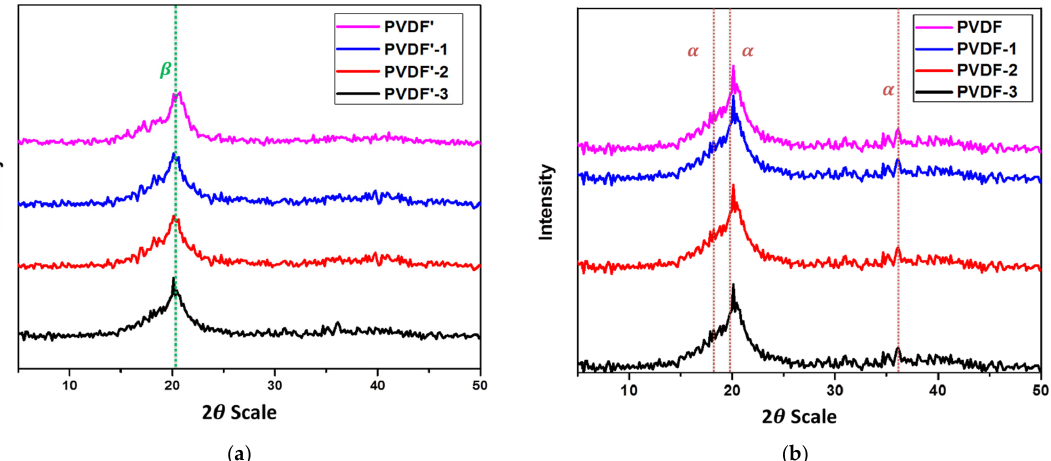
Figure 4. FTIR spectra of ( a ) electrospun PVDF fibrous membrane prepared in 100/0, 80/20, 60/40, and a 50/50 DMF/acetone solvent mixture. ( b ) FTIR spectra of PVDF flat-sheet membranes were prepared in 100/0, 80/20, 60/40, and 50/50 DMF/Acetone solvent mixture.